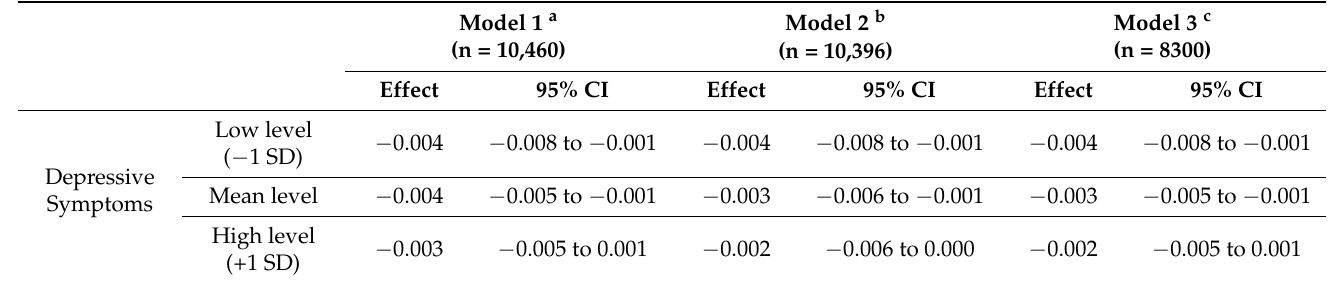
Table 5. The results of conditional indirect effect via depressive symptoms when sleep duration was used as a moderator.